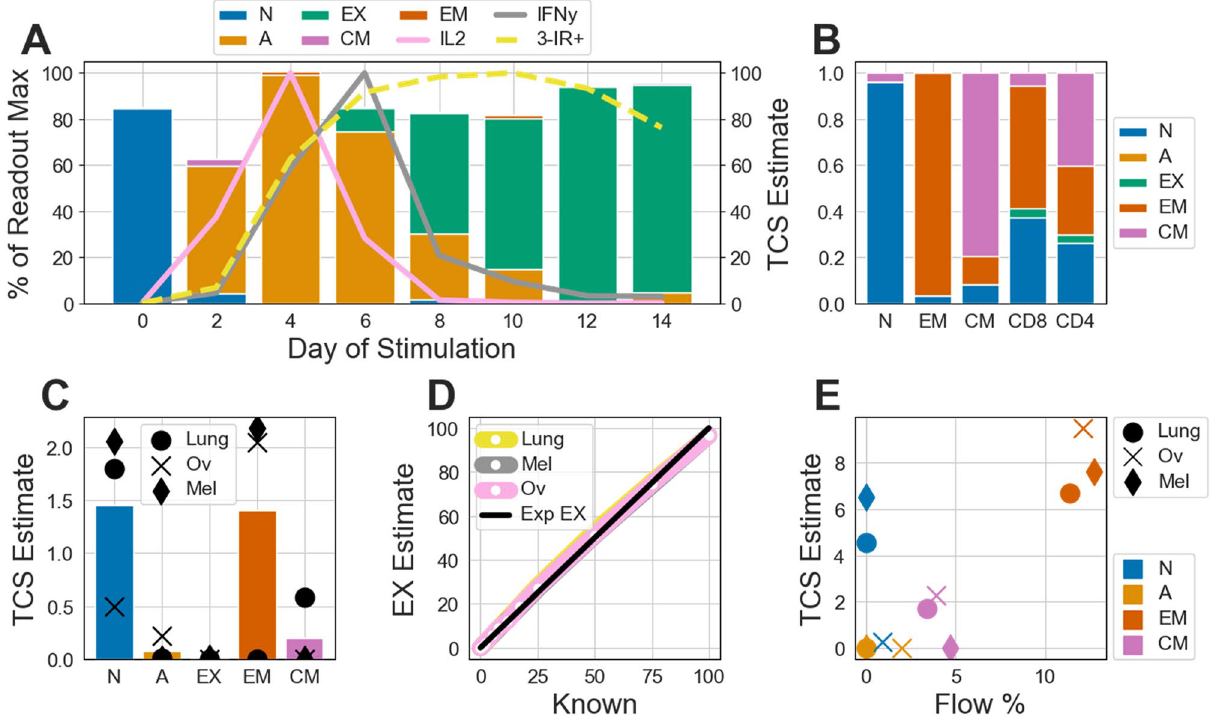
Figure 2. T Cell Subtype Profiling is analytically robust. ( A ) The transient change of naïve CD8+ T cells during a chronic stimulation in vitro model. Naïve CD8+ T cells were isolated from a donor and stimulated for 14 days. This donor was not used in creating the Subtype Health Expression Models (sHEMs). Every two days, the presence of the extracellular cytokines IL2 and IFNγ was measured via ELISA and the abundance of cells jointly expressing the PD1, TIM3, and LAG3 inhibitory receptors (3-IR+) was measured via flow cytometry. The IL2, IFNγ, and 3-IR+ readouts are independently normalized to their max expression during the time series and shown as lines (left y-axis). Cells were harvested every two days and characterized using T Cell Subtype Profiling (TCSP). T Cell subtype (TCS) estimates are shown as stacked bars (right y-axis). N naïve subtype; A activated subtype; EX exhausted subtype; EM effector memory subtype; CM central memory subtype. ( B ) The sum-normalized TCS estimates of T Cell populations isolated from blood: naïve CD8+ T cells (N, n = 5), effector memory CD8+ T Cells (EM, n = 5), central memory CD8+ T Cells (CM, n = 3), CD8+ T cells (CD8, n = 8), and CD4+ T cells (CD4, n = 8). ( C ) TCSP of CD45− cells isolated from lung adenocarcinoma (Lung, n = 1), ovarian adenocarcinoma (Ov, n = 1), and melanoma (Mel, n = 1) tumor samples. Numbers shown are on a scale of 0 to 100. Bars show average estimated abundance of each TCS across all three tumors (points). ( D ) Exhaustion subtype estimates of synthetic samples comprised of varying fractions of chronically stimulated CD8+ T cells (day 14 from A ) and CD45− cells isolated from tumor samples (from C ). The expected exhaustion estimates (Exp EX) are shown as a black line. ( E ) TCSP of dissociated whole tumor samples (from C ) compared against % of CD45+ immune cells determined by canonical flow cytometry estimation (Flow %). Point shapes correspond to cancer type, while colors correspond to